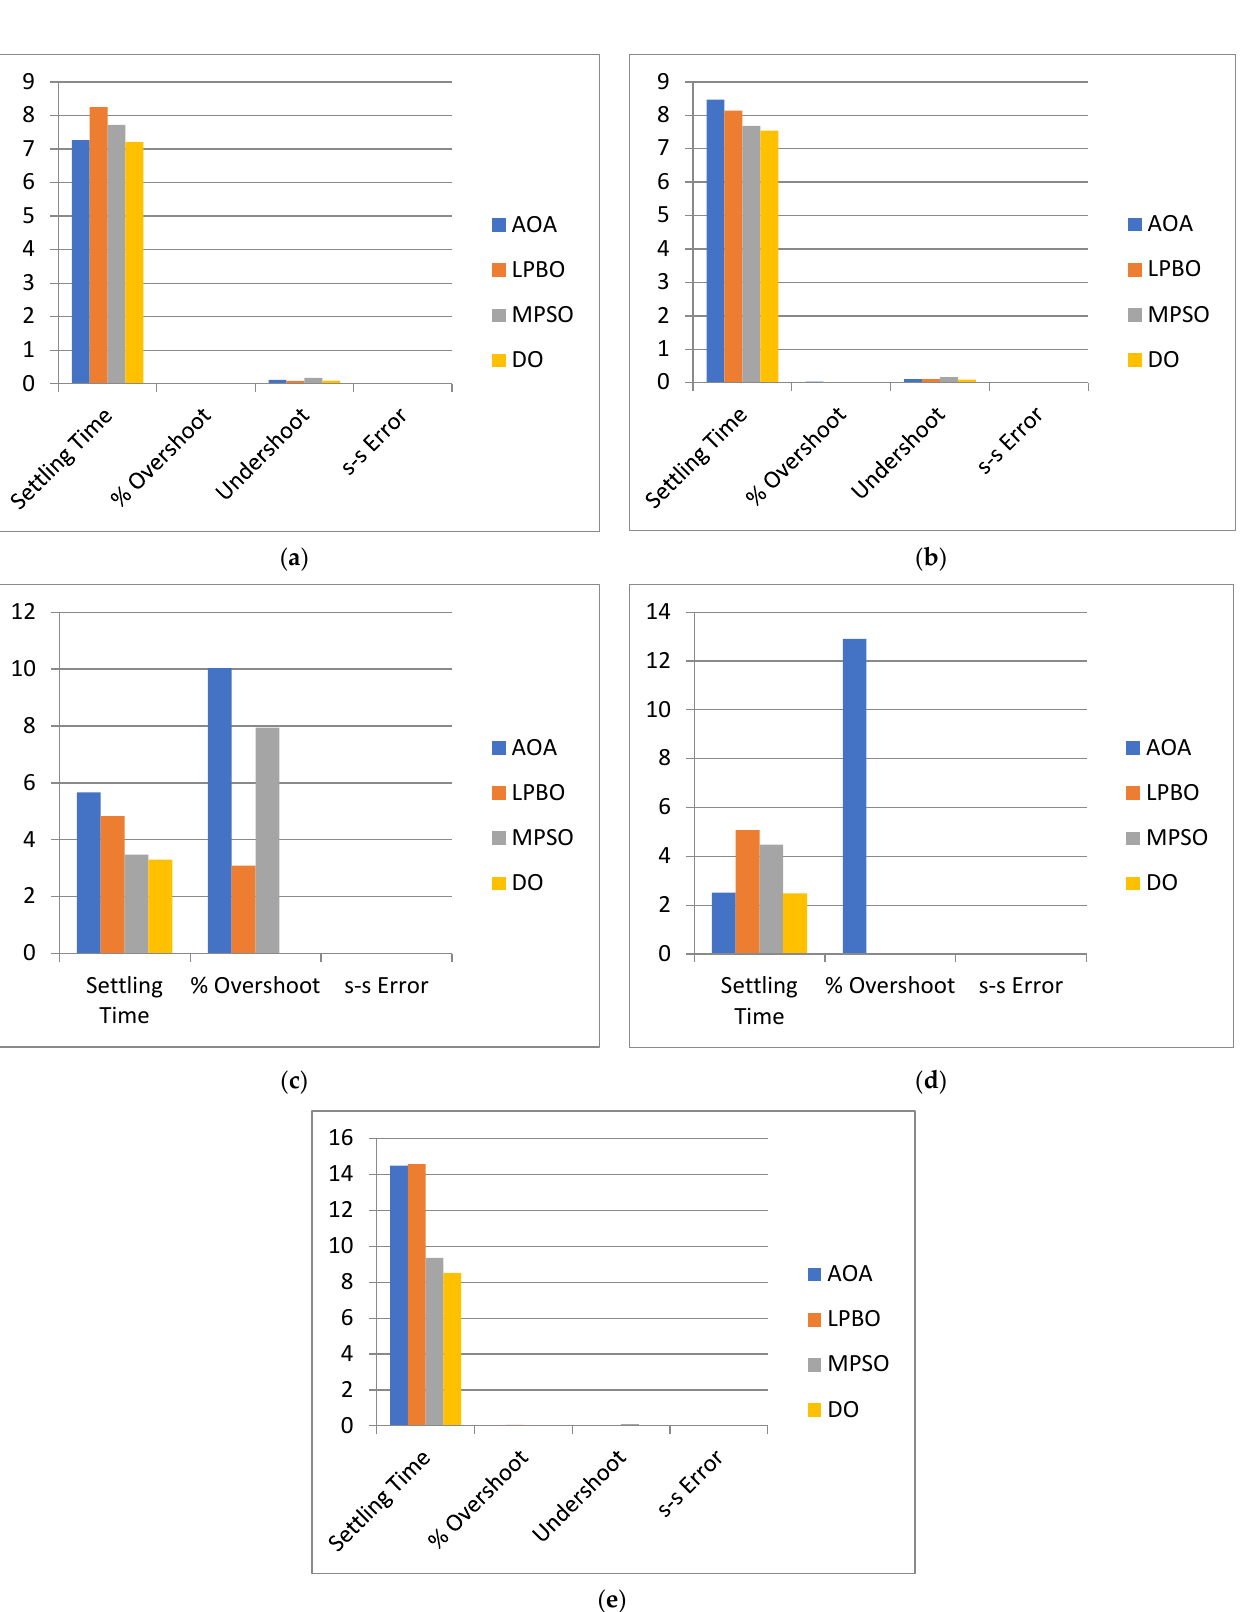
23 of 36 Figure 13. Tie-line power deviation responses in a two-area multi-source realistic IPS with nonline- arities. Table 11. Numerical results of tie-line power deviation in a two-area multi-source realistic IPS with nonlinearities. Control Scheme